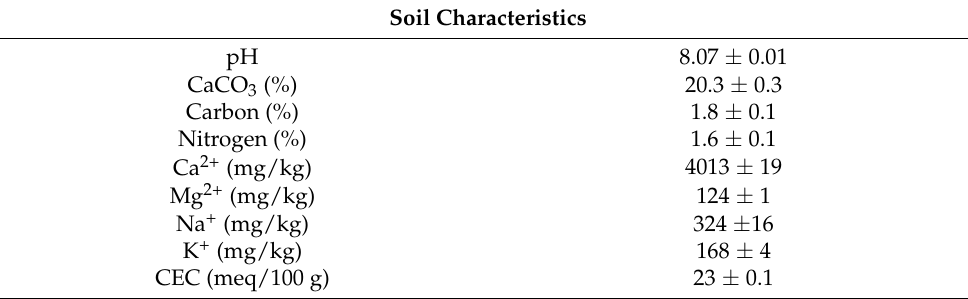
Table 1. Soil characteristics (mean ± standard